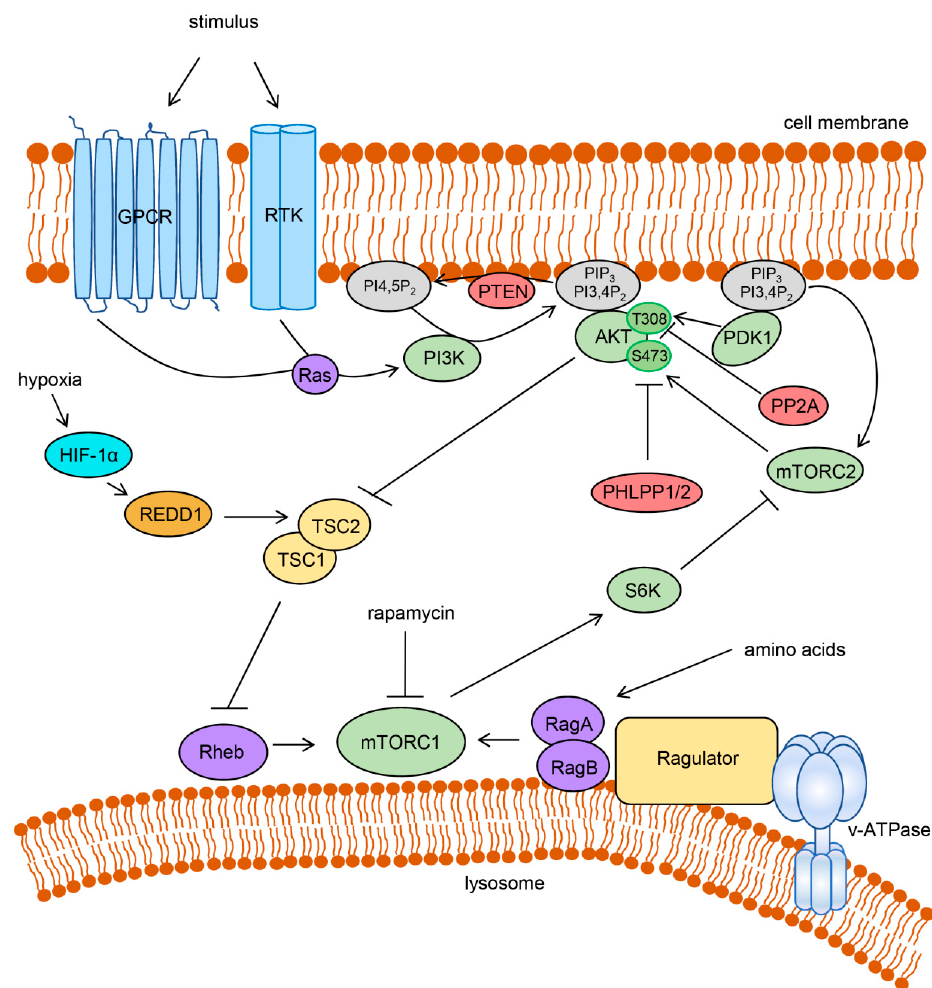
Figure 1. Activation and regulation of the PI3K/AKT/mTOR signaling network. Extracellular stimuli activate PI3K through GPCRs or RTKs, often involving Ras GTPases. Active PI3K produces PIP 3 and PI3,4P 2 that recruit AKT to the cell membrane. Phosphoinositide ‐ dependent PDK1 and mTORC2 activate AKT by phosphorylation. AKT activation is negatively regulated by direct dephosphorylation through PP2A and PHLPP1/2 and by dephosphorylation of phosphoinositides through phosphatase and tensin homolog (PTEN). AKT can activate mTORC1 by inhibiting tuberous sclerosis complex 2 (TSC2), which in complex with TSC1, acts as a GTPase activating protein (GAP) for Rheb. Rheb as well as the RagA:RagB heterodimer is required for the activation of mTORC1. The amino acid ‐ dependent RagA:RagB interacts with the lysosome ‐ associated protein complex Ragulator that is bound to the lysosomal v ‐ ATPase. mTORC1 activity can be inhibited under hypoxia by HIF ‐ 1 α‐ mediated transcriptional stimulation of REDD1 (regulated in development and DNA damage response 1) which activates TSC2. mTORC1 can orchestrate a negative feedback regulation, for instance by inhibition of mTORC2 through the activation of S6K. Rapamycin directly inhibits mTORC1 but not mTORC2. Arrows indicate an activation, bar ‐ headed lines indicate an inhibition.